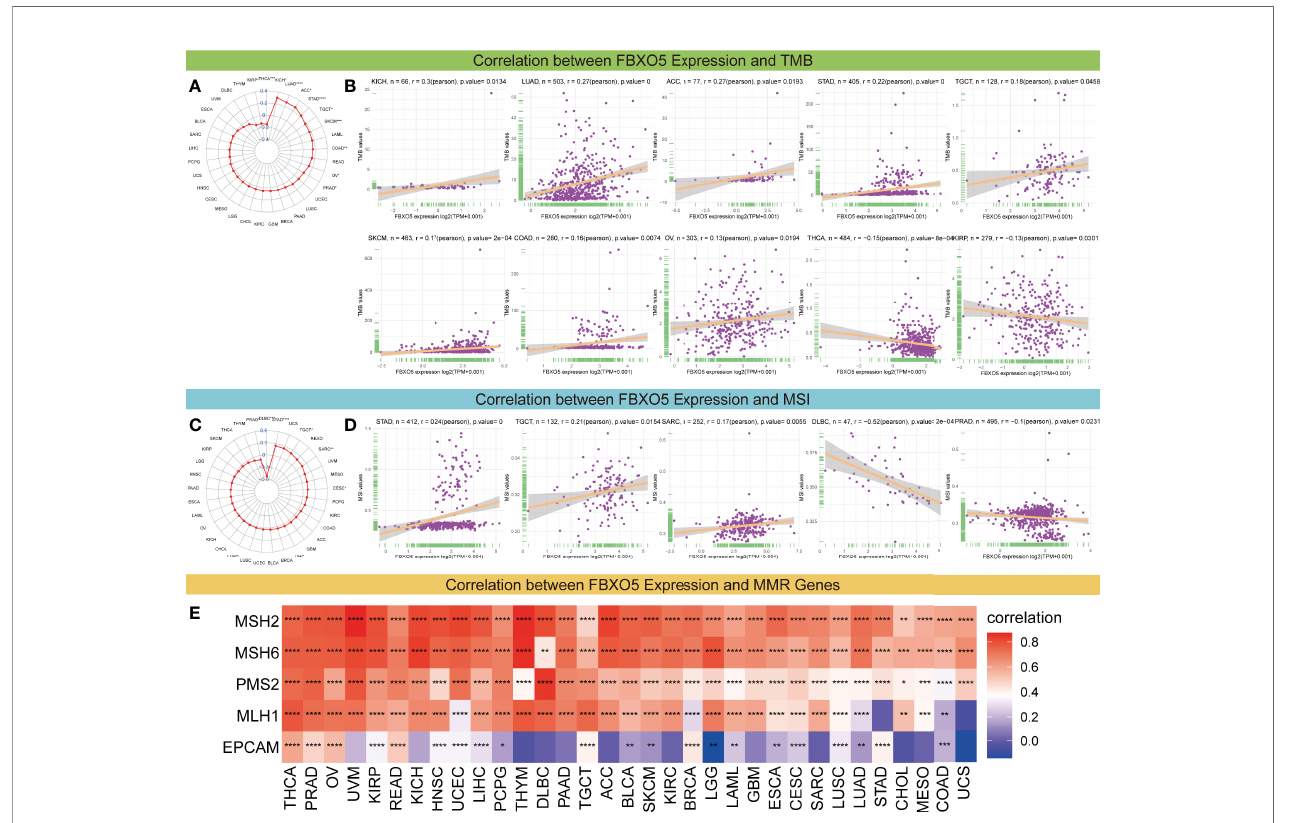
FIGURE 8 | Correlations of FBXO5 expression with TMB, MSI, and MMR. (A) Radar map of the association between FBXO5 expression and TMB levels in pan- cancer. The values in blue stand for the range and the lines in red stand for the correlation coef fi cients. (B) Pearson ’ s correlation between FBXO5 expression and TMB levels in the indicated cancers. (C) Radar map of the association between FBXO5 expression and MSI frequencies in pan-cancer. (D) Pearson ’ s correlation between FBXO5 expression and MSI frequencies in the indicated cancers. (E) Heatmap illustrating the association between FBXO5 expression and fi ve MMR genes (MSH2, MSH6, PMS2, MLH1, and EPCAM) in pan-cancer. * p -value < 0.05, ** p -value < 0.01, *** p -value < 0.001, and **** p -value <